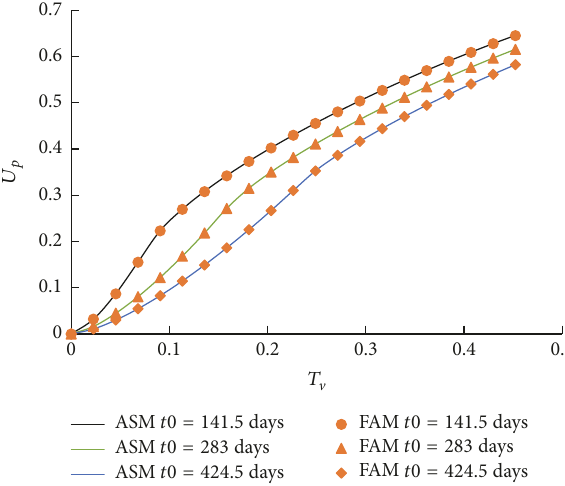
Figure 6: 𝑈 𝑝 versus 𝑇 V curves for single ramp